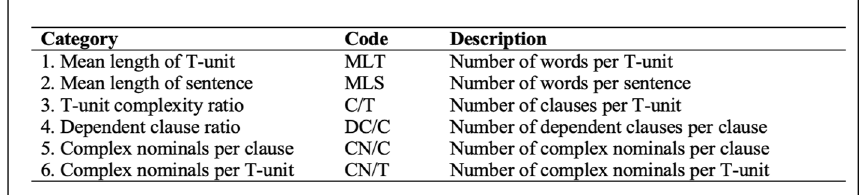
Fig. 2 Measurement variables for syntactic